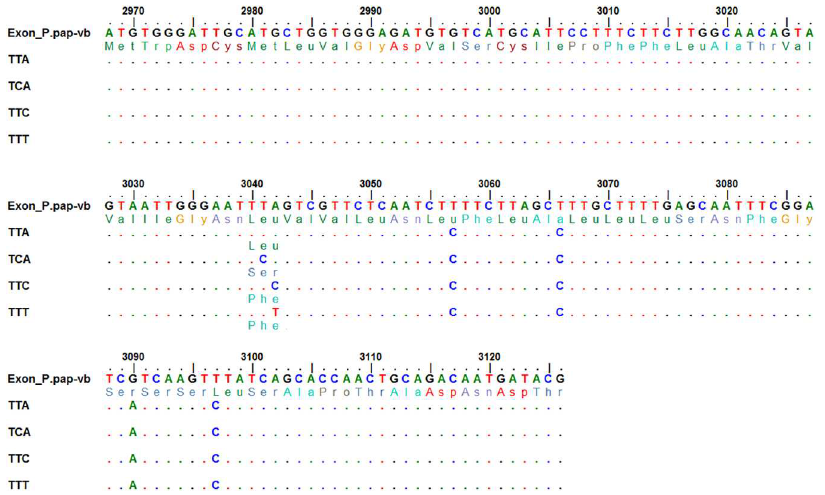
Fig 1. Sequence alignment of the Vgsc in P . argentipes with the sequence of P . papatasi . Nucleotide numbering is based on the house fly para sodium channel(Genbankaccession number: